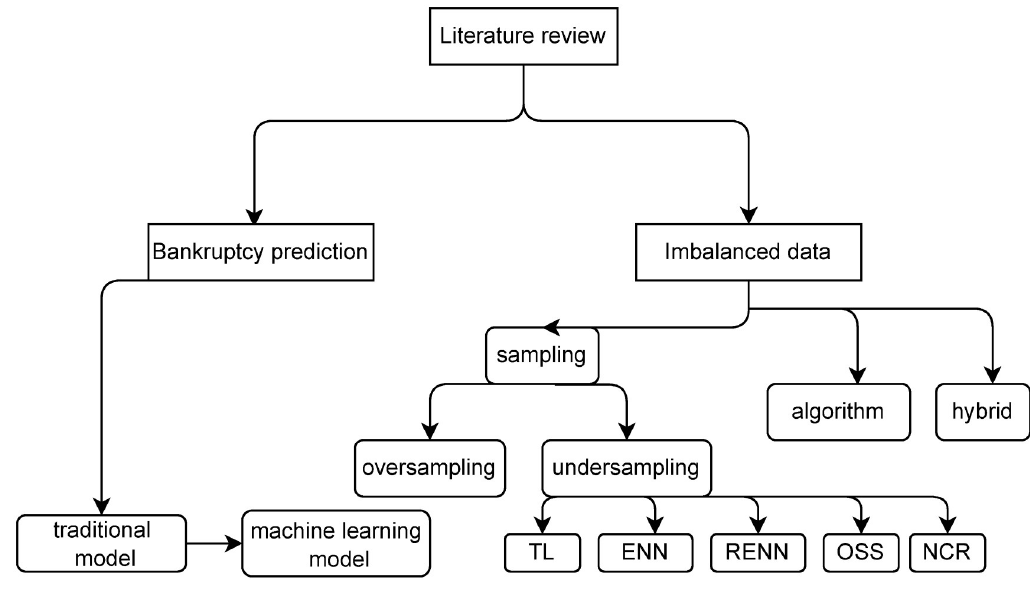
Fig 1. Organization figure. Structure of literature